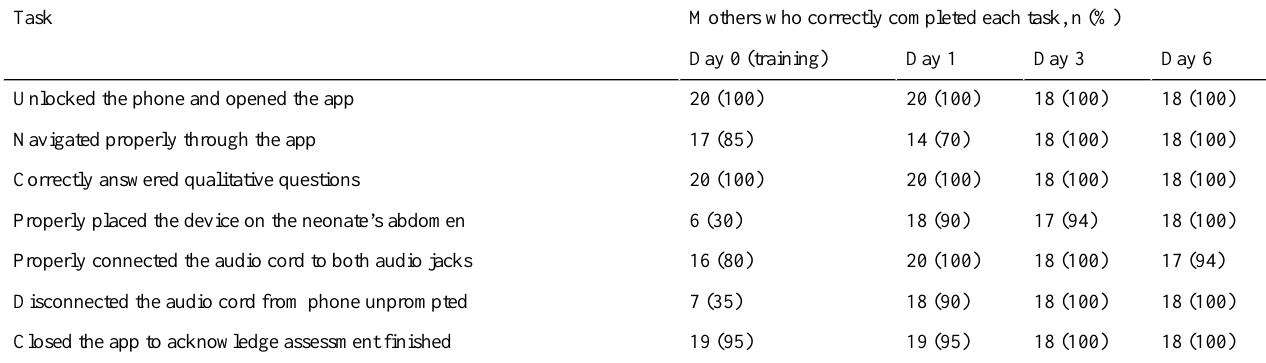
Table 2. Percentage of mothers who correctly completed each task during the observed uses on neonates.